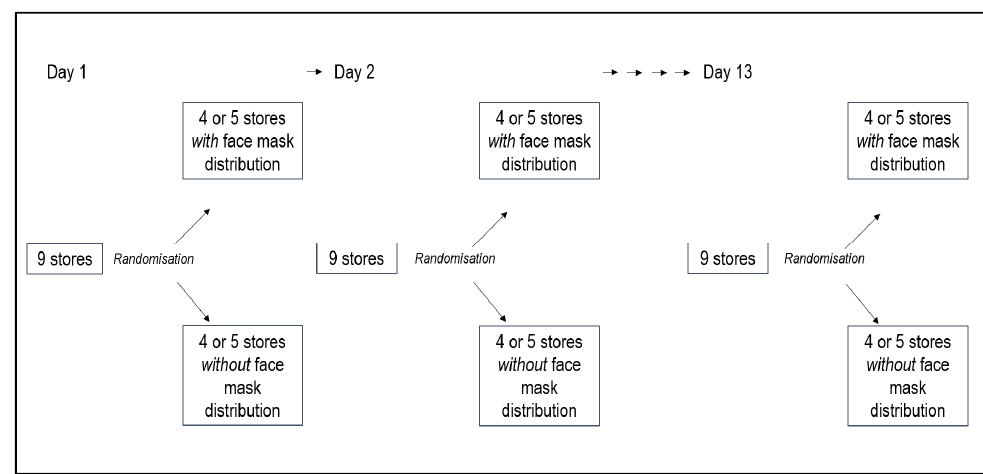
Figure 2. Randomisation procedure.